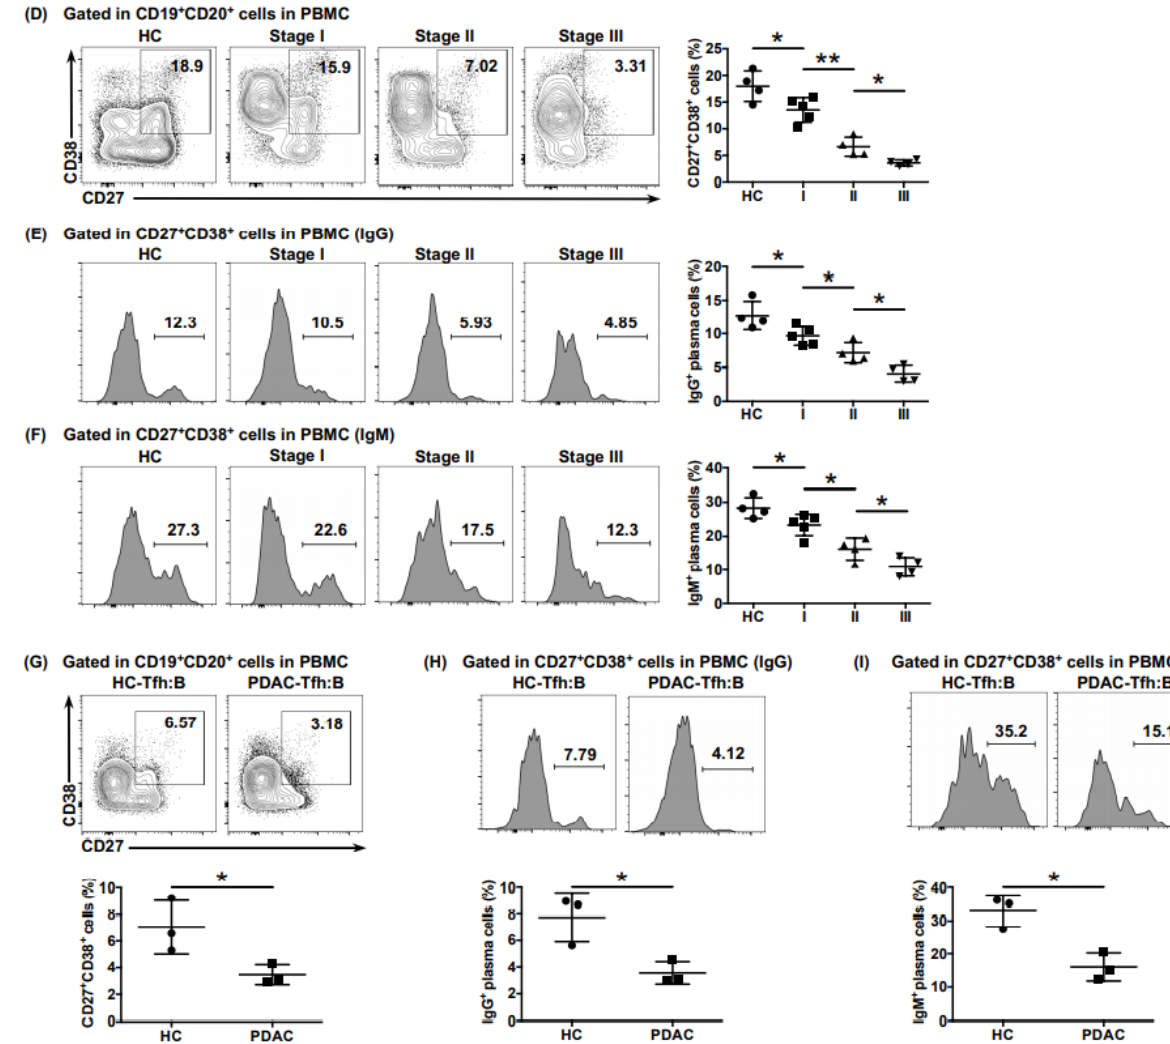
Figure 3. The anti-tumor function of Tfh cells was impaired in PDAC. ( A ) Representative flow cytometry data and the proportion of functional cTfh cells (CXCL13 + IL-21 + ) from the peripheral blood of healthy donors ( n = 4) and patients with PDAC of different stages ( n I = 5, n II = 4, n III = 4). ( B ) Representative flow cytometry data and ( C ) the proportion of CD8 + T cells and B cells recruited to the bottom of the Transwell chamber by cTfh cells treated with or without rhCXCL13 or anti-CXCL13 neutralizing antibodies. ( D ) Representative flow cytometry data and the proportion of plasma cells (CD27 + CD38 + ) in B cells (CD19 + CD20 + ) from the peripheral blood of healthy donors ( n = 4) and patients with PDAC at different stages ( n I = 5, n II = 4, n III = 4). ( E ) Representative flow cytometry data and the proportion of IgG-secreting plasma cells from cells in ( D ). ( F ) Representative flow cytometry data and the proportion of IgM-secreting plasma cells from cells in ( D ). ( G ) Representative flow cytometry data and the proportion of plasma cells (CD27 + CD38 + ) in B cells (CD19 + CD20 + ) co-cultured with cTfh cells sorted from the peripheral blood of healthy donors ( n = 3) and patients with PDAC ( n = 3). ( H ) Representative flow cytometry data and the proportion of IgG-secreting plasma cells from cells in ( G ). ( I ) Representative flow cytometry data and the proportion of IgM-secreting plasma cells from cells in ( G ). Asterisks indicated the significance level of the p -value (* p < 0.05 and ** p < 0.01).